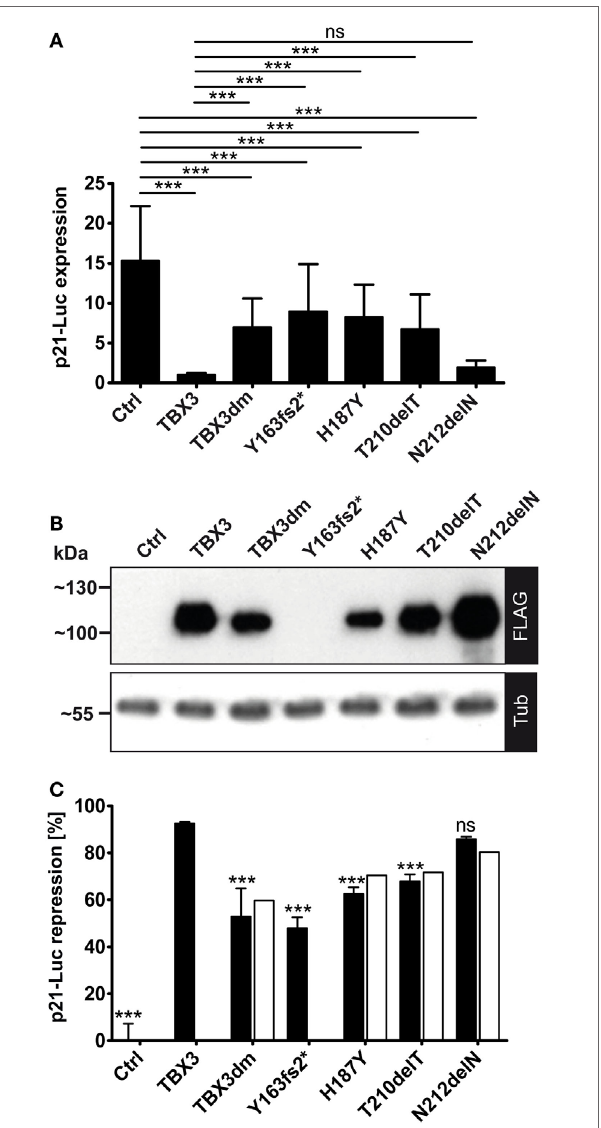
FigUre 4 | repression of a p21-luc reporter by TBX3 and mutant derivatives . (a) The repression of the p21-Luc reporter was measured with 25 ng of expression vector encoding the normal or mutant TBX3 proteins. For control, empty expression vector was transfected. Luc expression is in arbitrary units. The Luc data from six independent experiments were normalized to TBX3 ( = 1). Average and SD are shown. TBX3dm, Y163fs2*, H187Y, and T210delT were significantly weaker repressors than normal TBX3 but also differed significantly from control. The mutant N212delN did not differ significantly from normal TBX3; hence, was an effective repressor. (B) Quantification of protein expression. Protein expression was visualized by Western blot of cell extract and FLAG immunodetection. Protein load was controlled with anti-alpha-tubulin. (c) Normalization of Luc repression by TBX3 and mutant derivatives to their respective protein concentration. The luciferase activity values of one experiment, for which the protein expression data are shown in (B) , were normalized to the control ( = 100%). To obtain repression data, these values were subtracted from 100 (0% repression in the control) and shown as black columns (error bars are SD, n = 6 technical replicates). The values after normalization to the different protein levels (see Materials and Methods) are presented by white columns.